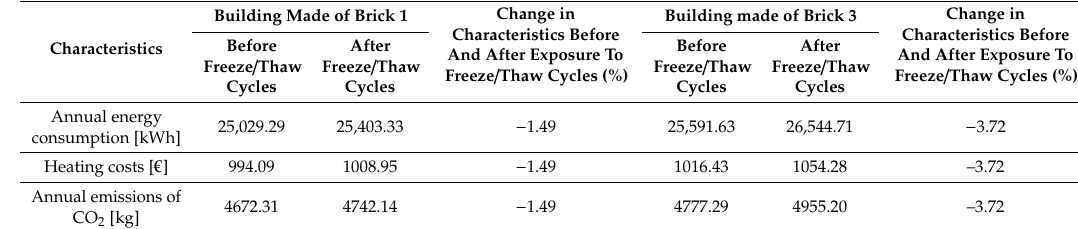
Table 8. Building major annual energy demand